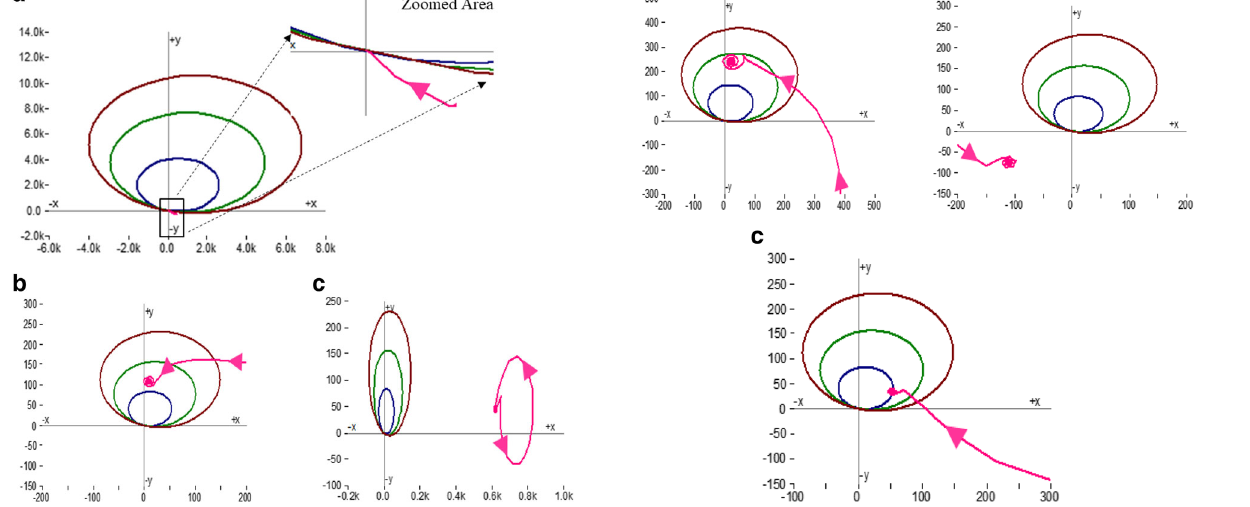
Fig. 6 Performance of ( a ) R 12 , ( b ) R 21 & ( c ) R 23 for LLL (RYB) fault at 10 km from Bus-1 (Zone-1 of R 12 and Zone-2 of R 21 ) with the proposed methodology